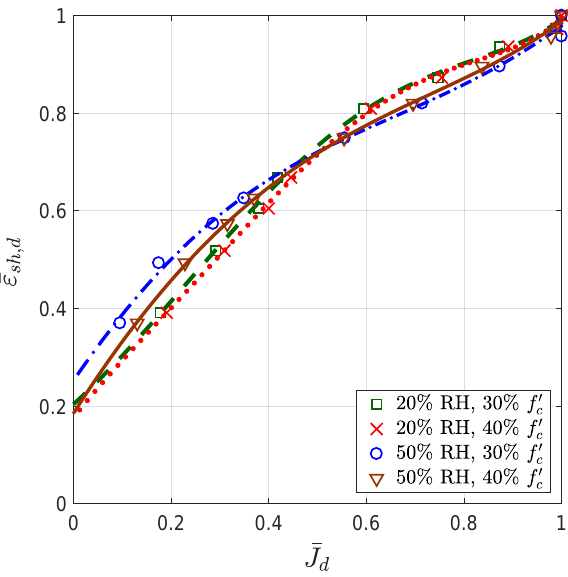
Figure 5. Comparison of normalized drying shrink- age and normalized drying creep evaluated from the experiments of Keeton at 20 % and 50 % relative hu- midity and two levels of loading. f 0 c is the compressive strength at the age of loading. Points are the experi- mental